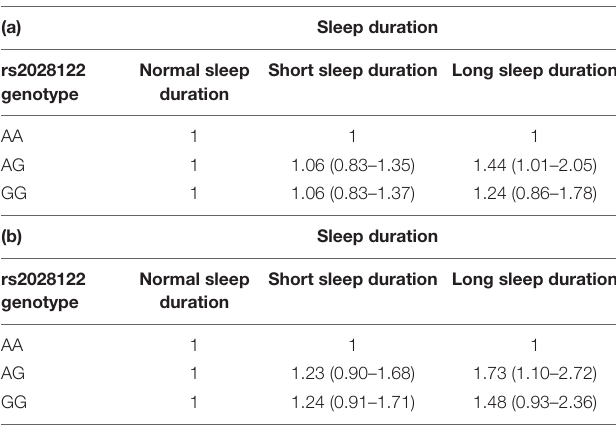
TABLE 3 | Interaction effect between rs2028122 genotype and sleep duration on PD